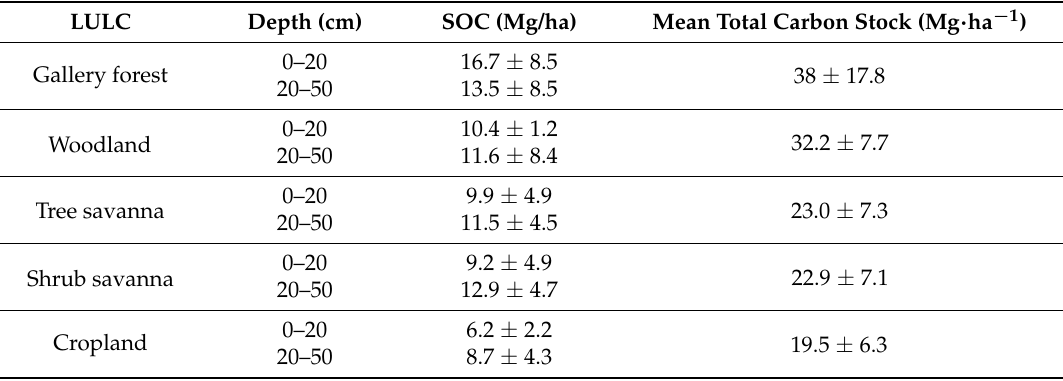
Table 5. Mean values (± standard error) of soil organic carbon in different LULCc and soil depths. The mean total carbon stock represents the stock of carbon stored in the plant biomass and in soil in different LULCc.